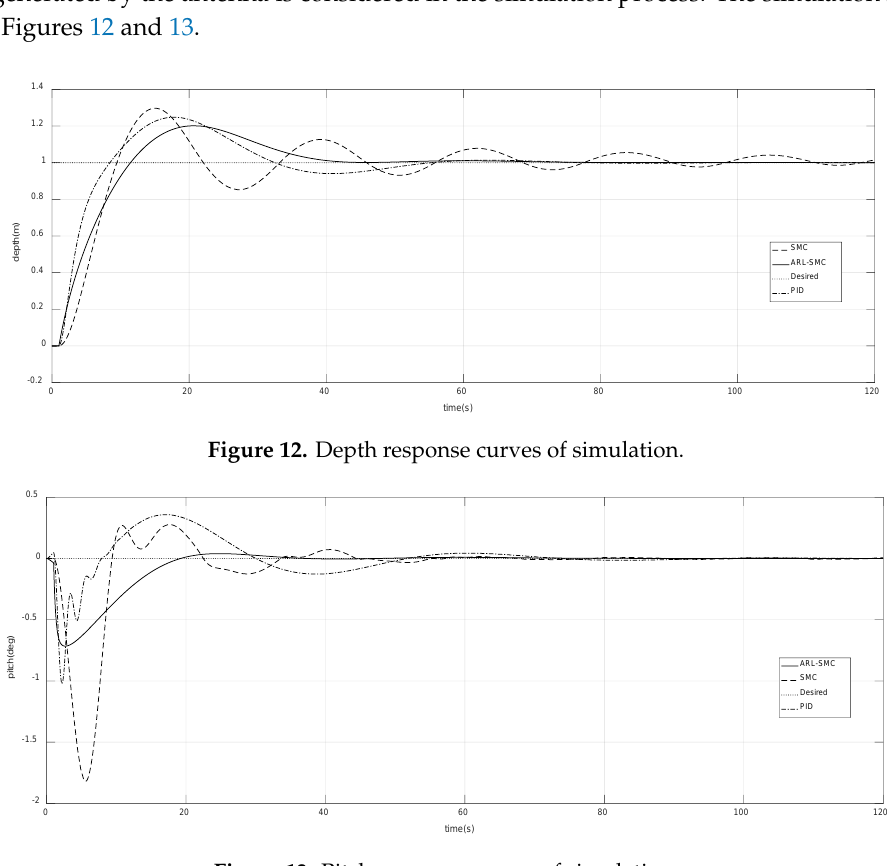
Figure 13. Pitch response curves of simulation.